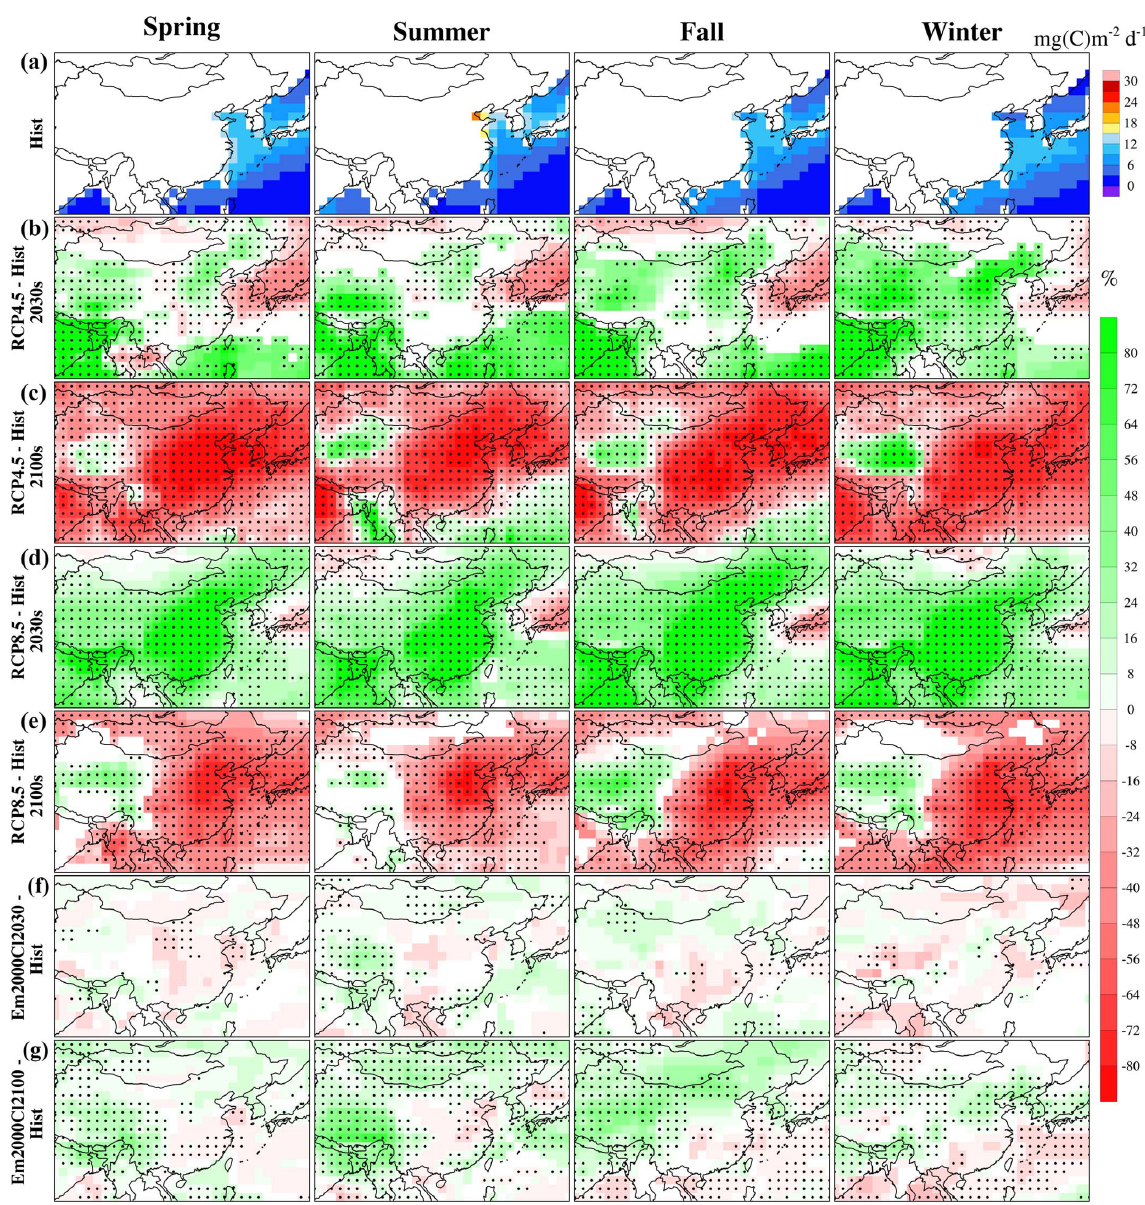
Figure 9. Panel (a) shows spatial distribution of marine primary production resulting from NO y deposition over East Asia in historical periods. Areas over land are blank because the Redfield ratio is only applied to the ocean areas. The spatial distributions in (b) – (g) refer to the percentage change of total NO y deposition for all RCP scenarios and other scenarios used in this study. Values in the ocean areas can be seen as changes of PP from NO y based on the definition of the Redfield ratio. In (b) – (g) all distributions are the percentage change compared to the historical period and only values with agreement are shown. Values with statistical significance ( α = 0 . 05) are marked with a black